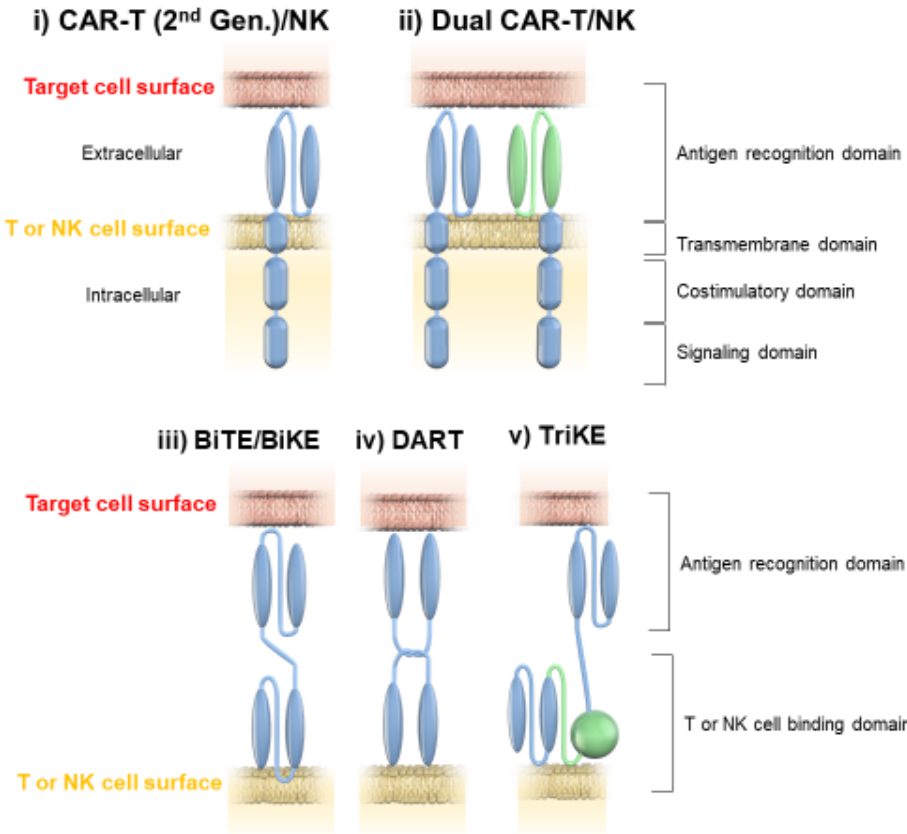
Figure 1. The structural characteristics of ( i ) chimeric antigen receptor (CAR) transgenic T-cell (T)/CAR-natural killer (NK), ( ii ) dual CAR-T/CAR-NK, ( iii ) bispecific T-cell engager (BiTE)/bispecific killer cell engager (BiKE), ( iv ) dual affinity retargeting (DART), and ( v ) trispecific killer cell engager (TriKE) therapies. CARs consist of an extracellular domain generated by a single-chain variable fragment (scFv) molecule, a hinge region connected to the transmembrane domain and an intracellular receptor portion. One or 2 costimulatory signaling domains, CD28 and/or 4-1BB, are added within the intracellular domain of CAR. The signaling domain is the zeta domain of a T-cell receptor/CD3 complex. BiTEs are composed of a VH domain linked to a VL domain via a short, flexible linker. A BiTE is composed of a scFv, whereas DART molecules are synthesized by cross-linking 2 variable fragments. It is a dual specificity of BiKE and targets NK cell specific antigens such as CD16 to engage NK cells, although its molecular structure is similar to BiKE. TriKE has triple specificity because in addition to CD16 and tumor antigen recognition sites specific for NK cells, it also has interleukin 15, which sends a proliferation signal to NK cells that are engaged by the tumor.